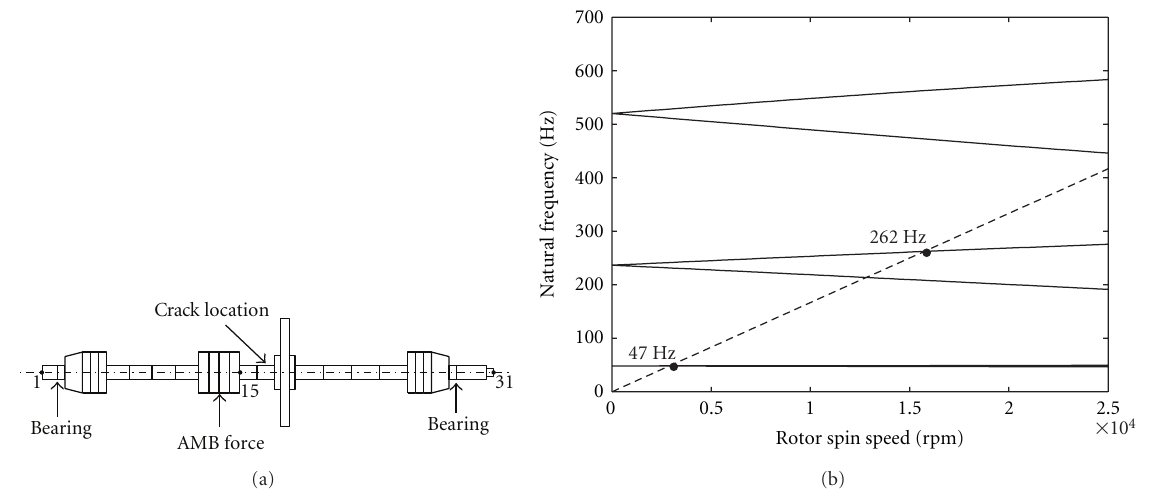
Figure 2: (a) Finite element model of the rotor test rig. (b) Campbell diagram for the undamaged rotor.